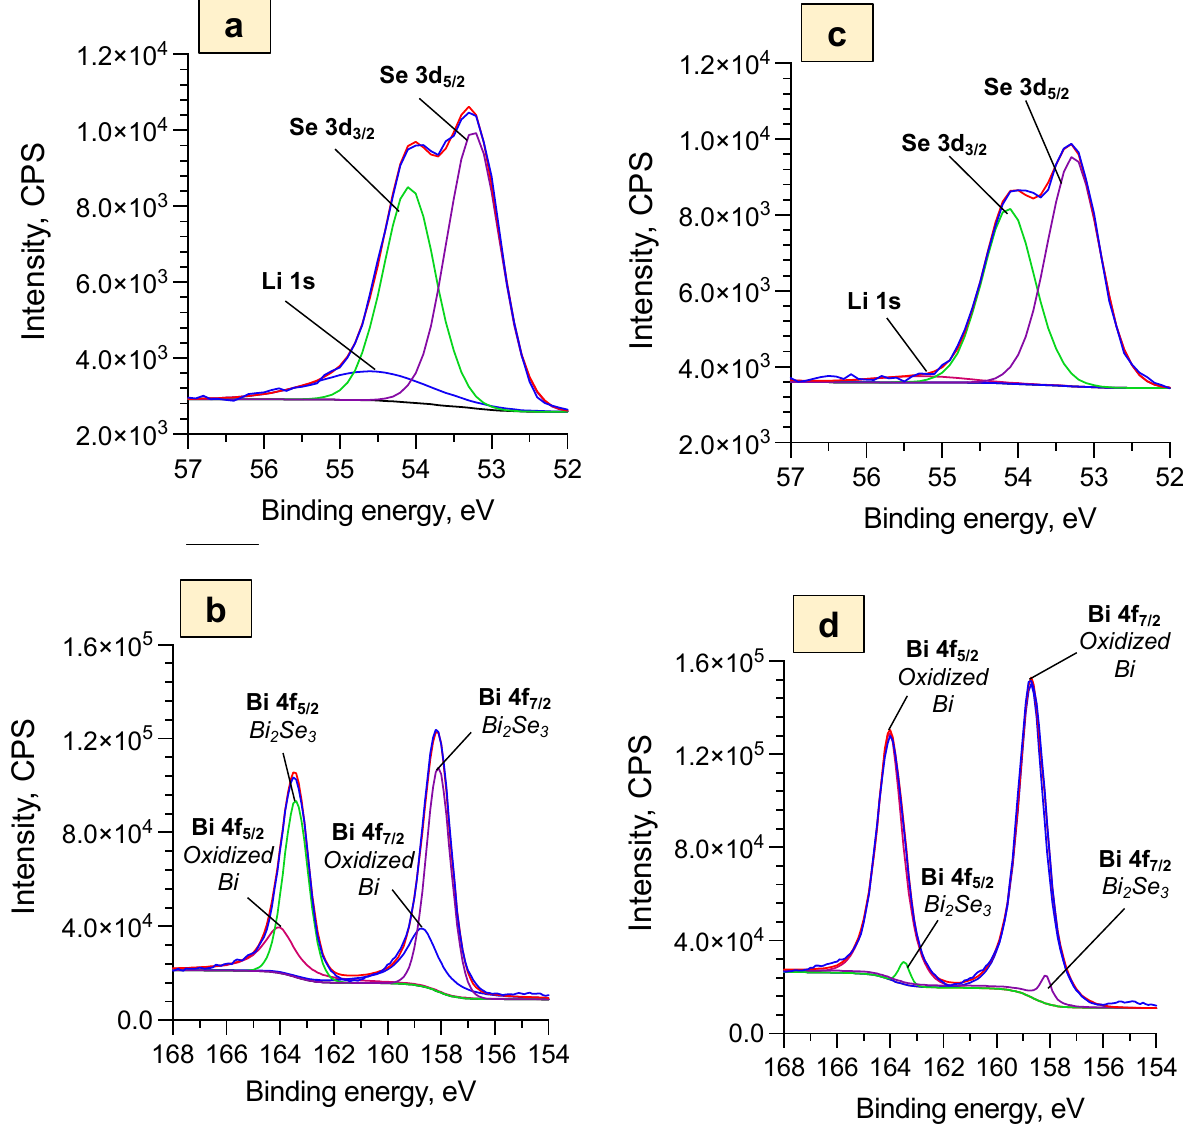
Figure 5. XPS spectra of Bi 2 Se 3 thin films in 5 M LiNO 3 after cyclic voltammetry measurements for: ( a )—SEI layer Se 3d and Li 1s data after 5 cycles ( − 1.0 V ÷ 1.3 V), ( b )—SEI layer Bi 4f data after 5 cycles ( − 1.0 V ÷ 1.3 V), ( c )—Bi 2 O 3 layer Se 3f and Li 1s data after 10 cycles ( − 1.0 V ÷ 0.5 V), ( d )—Bi 2 O 3 layer Bi 4f data after 10 cycles ( − 1.0 V ÷ 0.5 V). Table 1. The atomic composition of Bi 2 Se 3 thin films in 5 M LiNO 3 before and after CV measurements. After 5 Cycles After 10 Cycles Element Before (SEI Layer) (Bi 2 O 3 Layer) Bi 41 ± 1 46 ± 3 41 ± 1 Se 59 ± 1 54 ± 3 59 ± 1 Charge/discharge profiles up to 100 cycles for the samples with the SEI and Bi 2 O